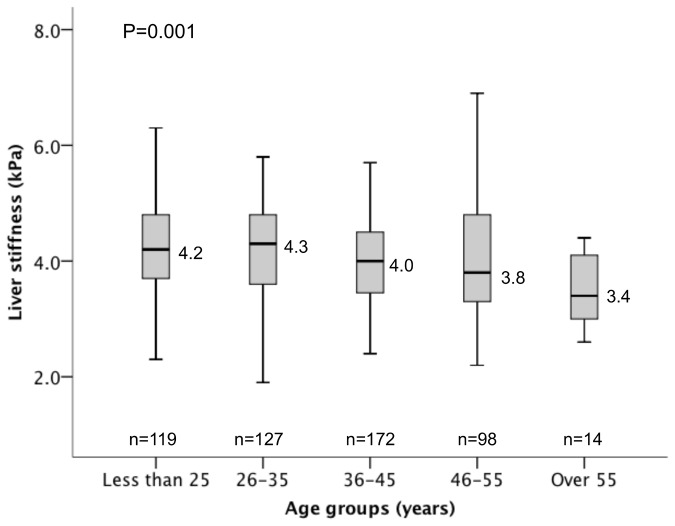
Liver stiffness according to different age groups.